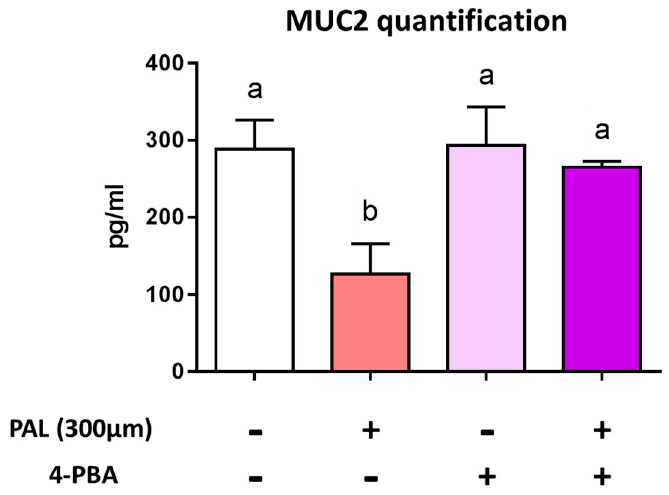
Figure 3. Preventing endoplasmic reticulum stress restores palmitic acid-altered MUC2 secretion. LS174T cells were treated for 24 h with control BSA, 300 µM PAL, or 500 µM 4-PBA, or were co-treated with PAL and 4-PBA. After incubation, cell culture supernatants were centrifuged to remove cell debris and the Muc2 protein released by LS174T cells was then quantified by ELISA. Results are presented as the mean ± SEM. of three independent experiments. Differences were analyzed by Tukey’s multiple comparison test. Bars assigned different superscript letters (a, b, c) were statistically different at p < 0.05. BSA: bovine serum albumin; PAL: palmitic acid; 4-PBA: 4-phenyl butyrate acid.